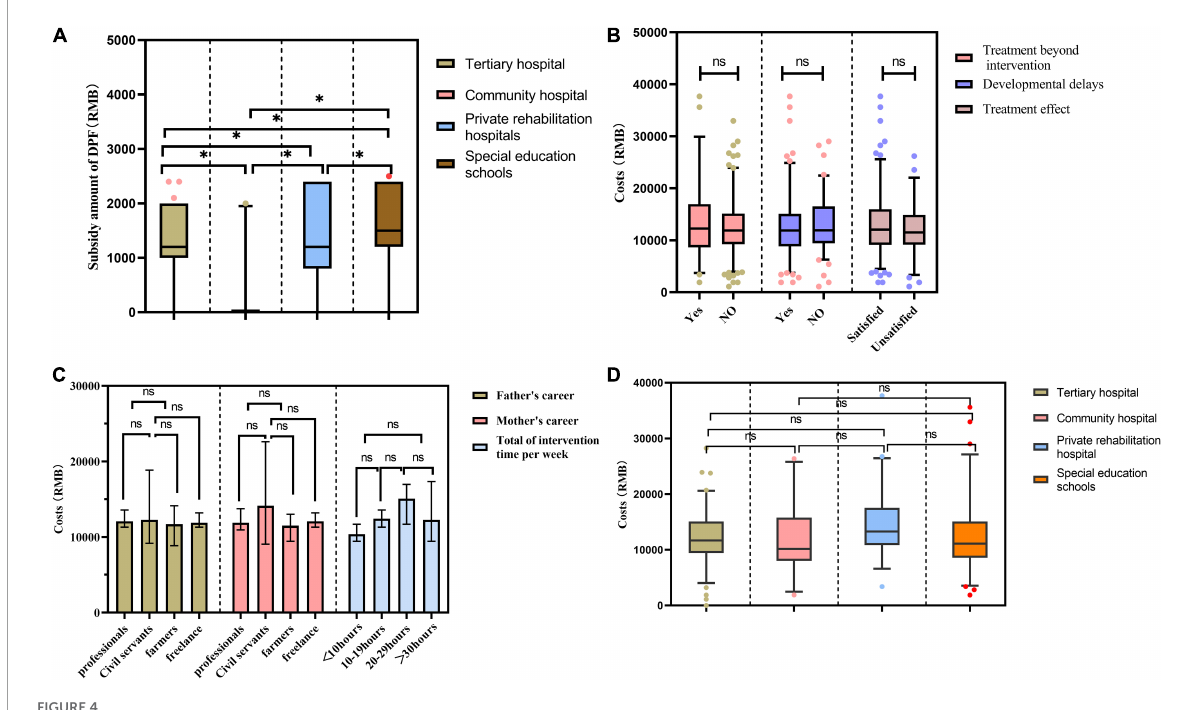
FIGURE4 Impacts of different factors on rehabilitation costs. * p < 0.05; ns, p >